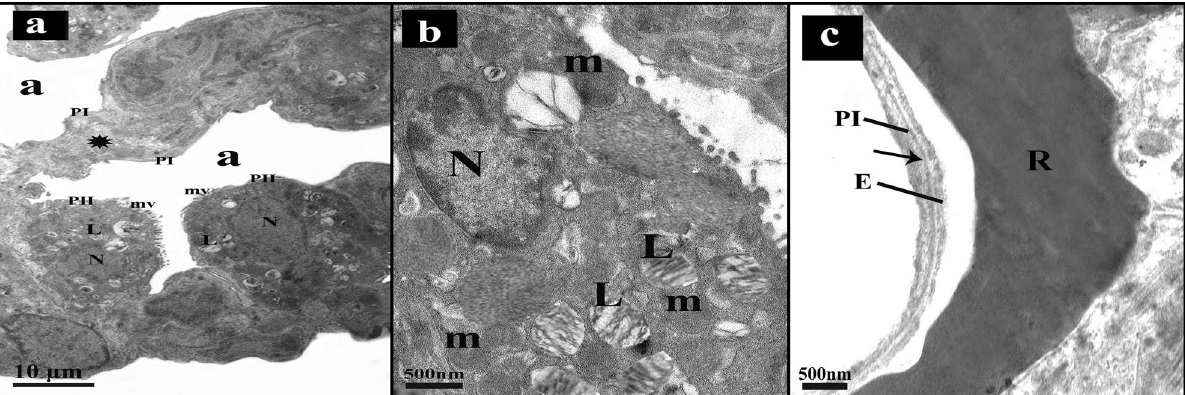
Figure 4. An electron micrograph of sections in lung of control group. ( a) The alveoli (a) lining are type I pneumocytes (PI) separated by thin interalveolar septa (*) and type II pneumocytes (PII) with central regular nucleus (N), lamellar bodies (L) and short microvilli (mv). ( b) Pneumocytes type II (PII) have central regular nucleus (N), lamellar bodies (L), mitochondria (m) and short microvilli (mv). ( c) Blood air barrier is composed of thin cytoplasm of type I pneumocyte (PI), the fused basal laminae (arrow), and endothelial cells (E). Notice, RBCs (R) in the capillary lumen.